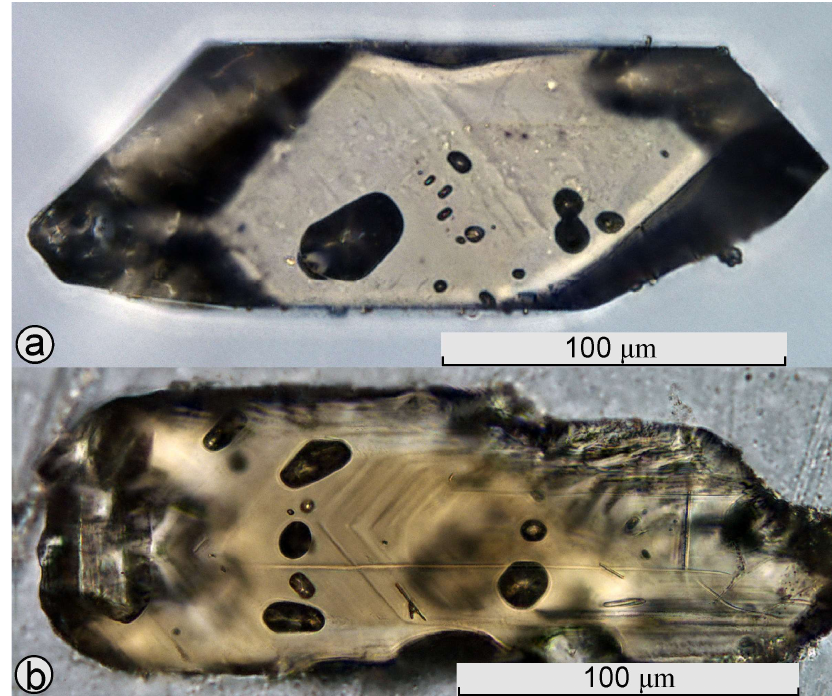
Figure 15. Typical zircon crystals from the studied rock under transmitted light. ( a )—euhedral; ( b )—not completely idiomorphic, with oscillatory zonality visible in an optical microscope. Presented in polished form, in epoxy resin. The images show melt silicate crystallized inclusions (transparent) and opaque inclusions of oxides (spinel group minerals, ilmenite) or sulfides (pyrrhotite or sulfide melt inclusions). Elongated transparent or needle-like inclusions with parallel faces are usually represented by apatite.